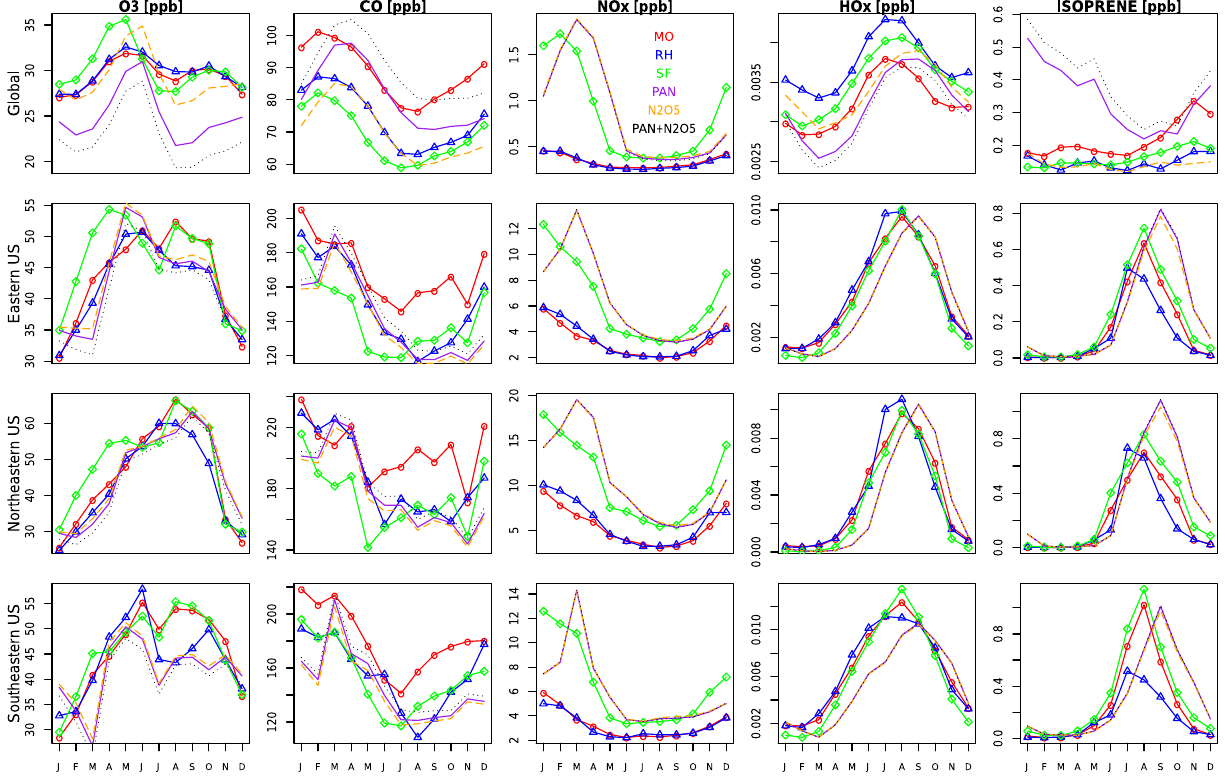
Figure 8. Seasonal time series for O 3 , CO, NO x , HO x , and ISOP for MO (red), RH (blue), and SF (green) for a single year (2015), averaged over different regions. The units are in ppb. Note the different scales in each panel. Also included are three sensitivity tests conducted with the SF mechanism (which were run for only 2 years, 1990–1991, with 1991 being plotted here): adding PAN chemistry (purple), adding N 2 O 5 chemistry (orange), and adding both PAN and N 2 O 5 chemistry